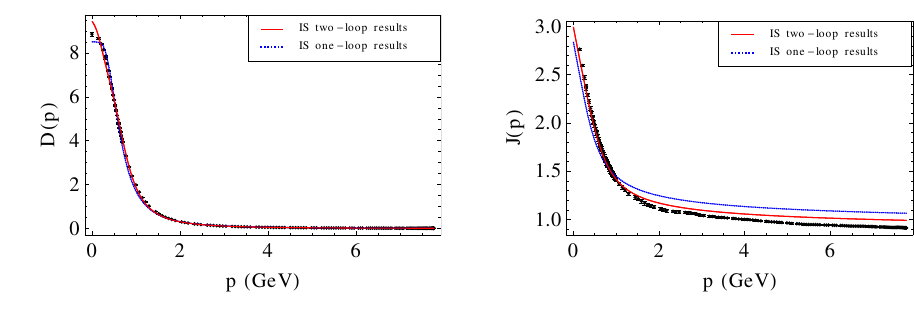
Figure 1. Gluon propagator and ghost dressing